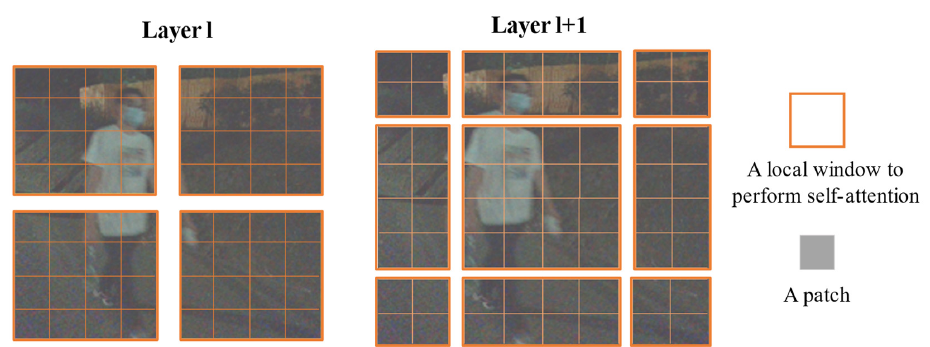
Figure 7. An illustration of the shifted-window approach.